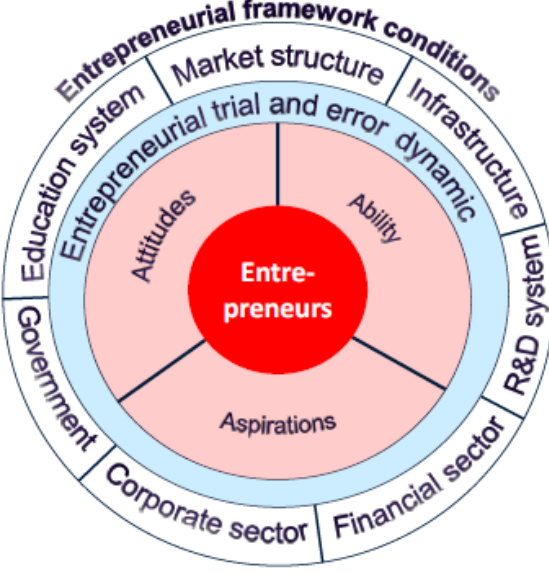
Figure 1. The ecosystem of global entrepreneurship [8].